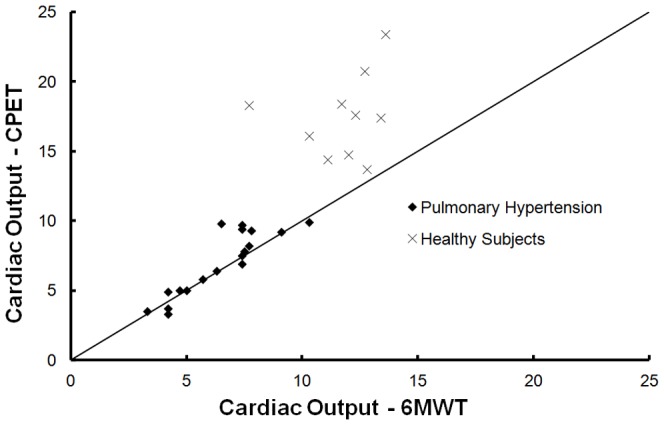
Cardiac output measured directly after the end of a 6MWT and of a CPET in 18 pulmonary hypertension patients and 10 healthy subjects.(-) Line of identity (where CO6MWT = COCPET).